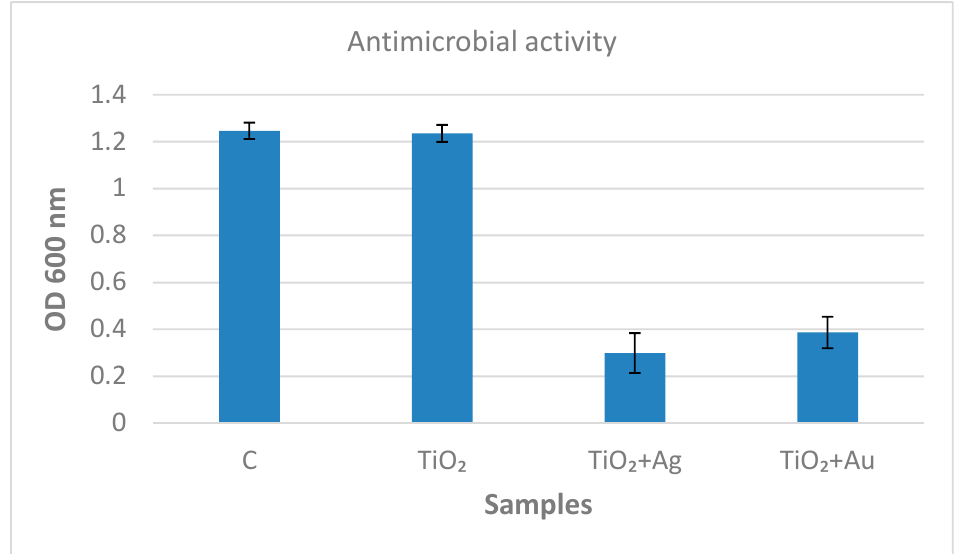
Figure 8. Microbial growth over the TiO 2 -based coatings of titanium.